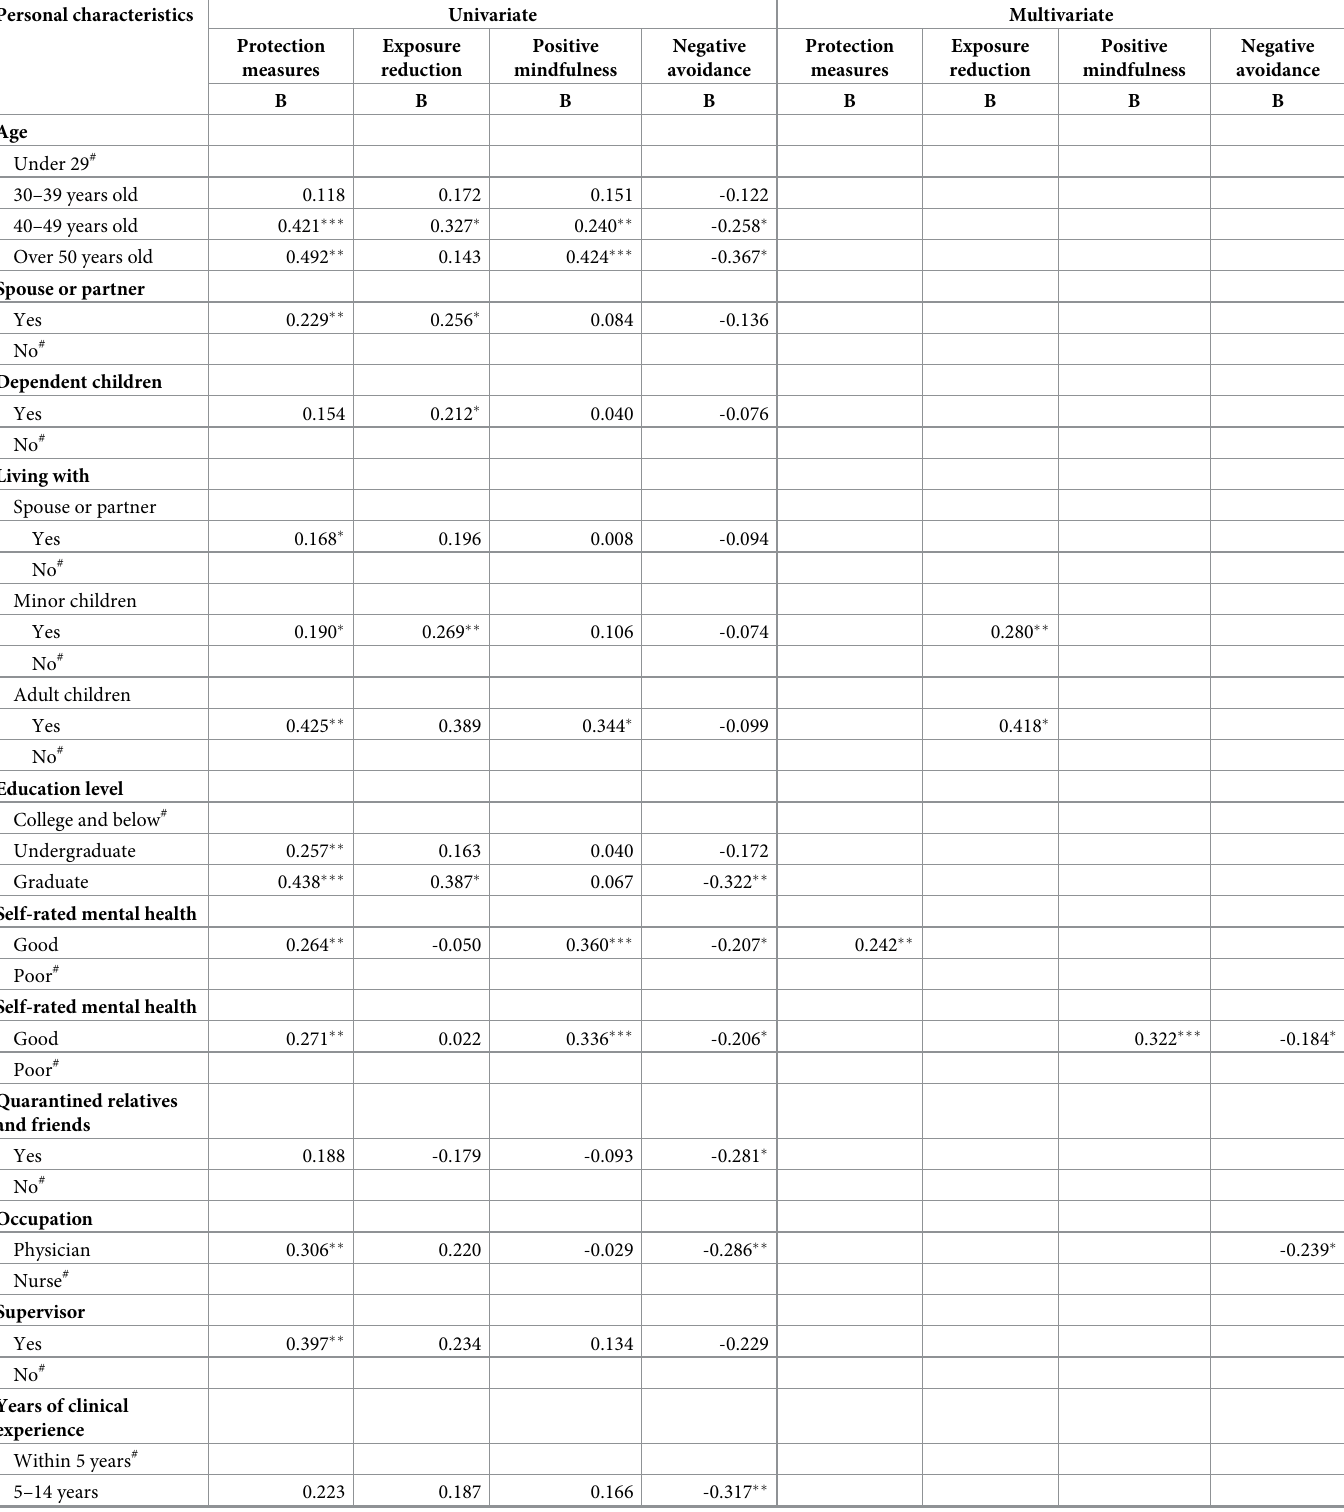
Table 4. Univariate and multivariate stepwise regression analysis of coping behaviors related